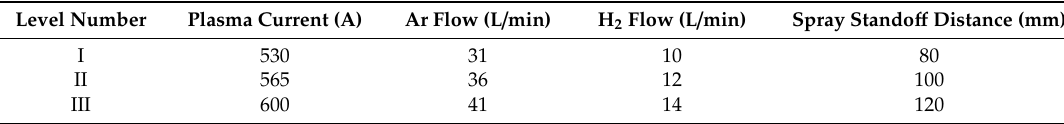
Table 1. Four factors and three levels for spraying A1 2 O 3 -13 wt.% TiO 2 (AT13) coatings.